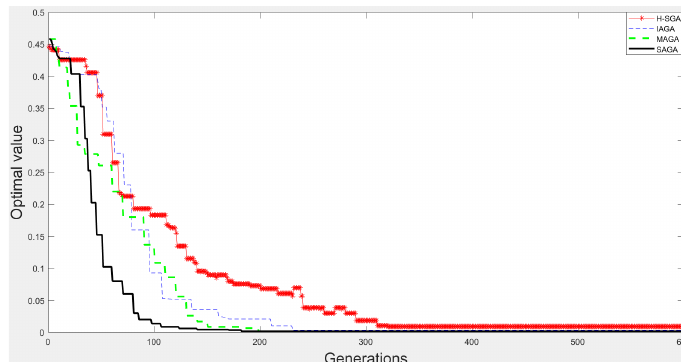
Figure 11. The experimental results on function F 3 .